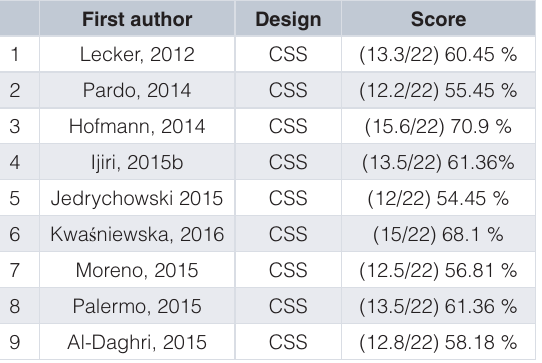
Table 4. Quality of the reporting of the results using the STROBE checklist. Score represents the number of items (with percentage of items) on the checklist that were reported satisfactorily in each study. Therefore, a high score represents a high adherence to reporting guidelines, while a low score represents low adherence to reporting